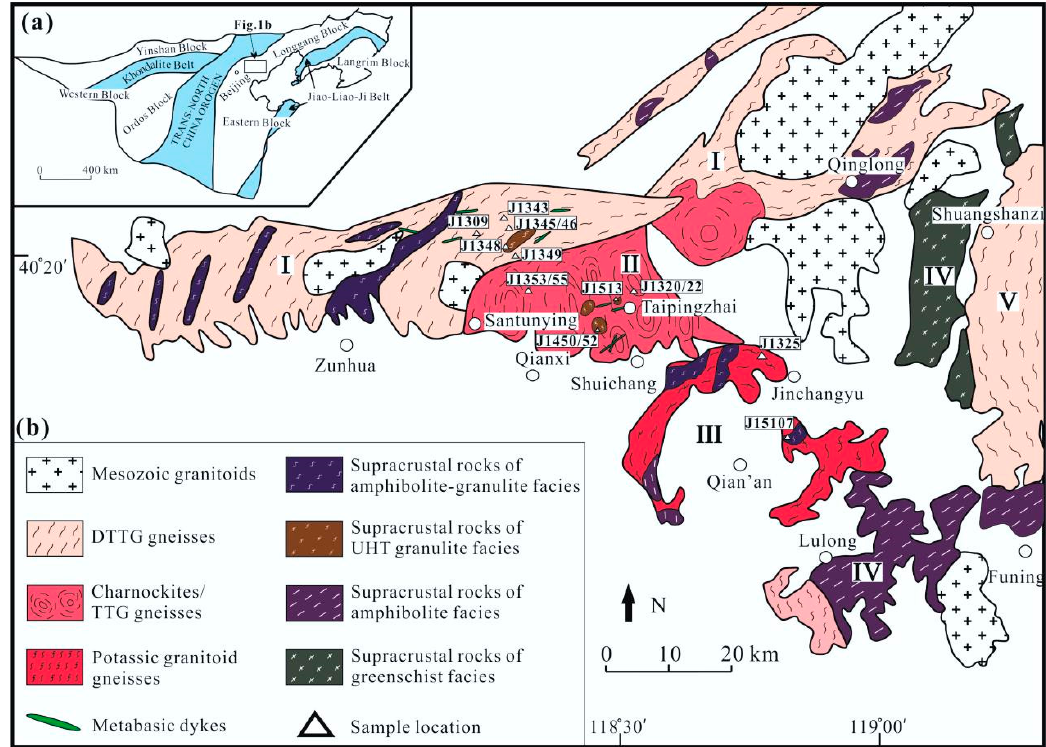
Figure 1. ( a ) Tectonic subdivision of the NCC [21] and the location of the study area. ( b ) Geological map of the Eastern Hebei terrane [40]. (I) the Saheqiao linear-structural belt; (II) The Taipingzhai ovate-structural domain; (III) The Qian’an gneiss dome; (IV) The Lulong–Shuangshanzi supracrustal belt; (V) The Anziling gneiss dome.